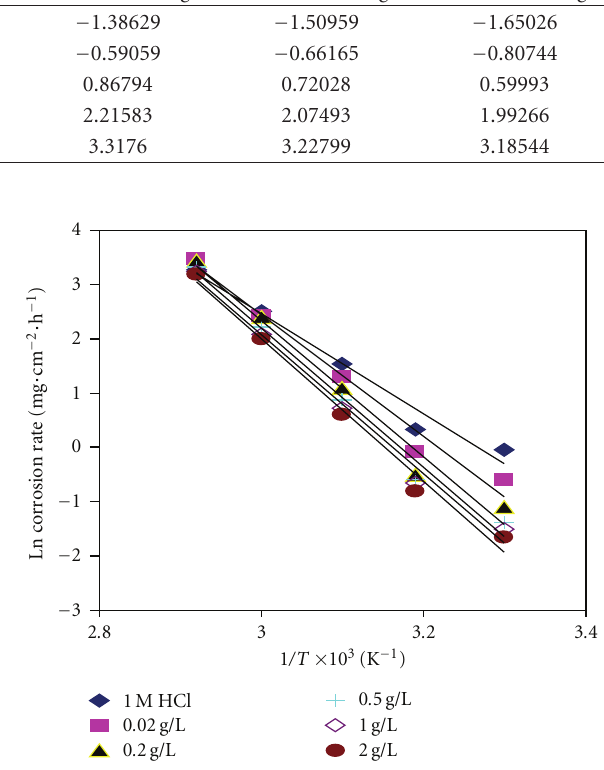
Figure 8: The Arrhenius plots of the corrosion rate of carbon steel in 1.0 M HCl solution with and without the presence of various concentrations of the aqueous extract of Neem